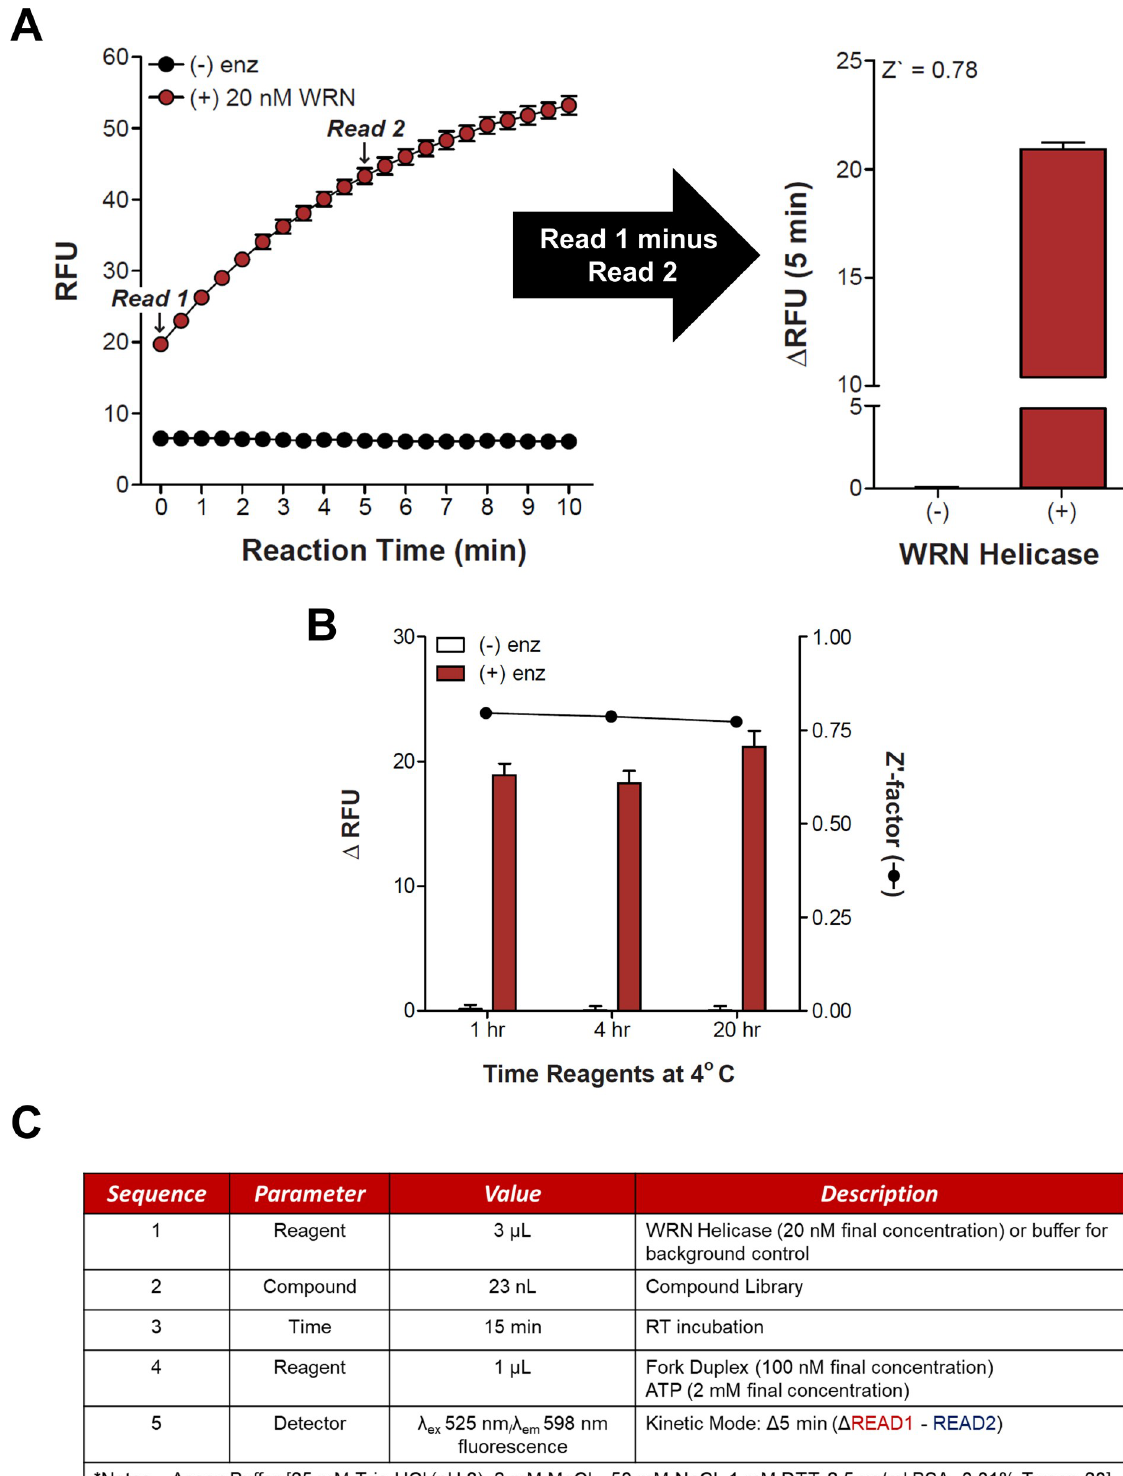
Fig 2. Fluorometric high-throughput helicase assay testing. (A) Graph of 20 nM E. coli-purified GST-WRN 500-946 unwinding of FORKF DNA substrate (100 nM) compared to the absence of enzyme from 0–10 min after reaction initiation, and a bar graph showing change in fluorescence between time points T = 0 and T = 5 min and the corresponding Z’-factor which was calculated at described in Materials and